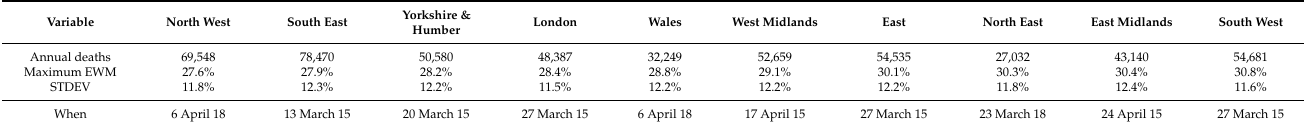
Table 3. Maximum value of EWM for regions in England and Wales (2010–2020) using weekly data, plus the standard deviation (STDEV) associated with the rolling EWM calculation, and the average annual deaths in each region. Variable NorthWest SouthEast Yorkshire& Humber